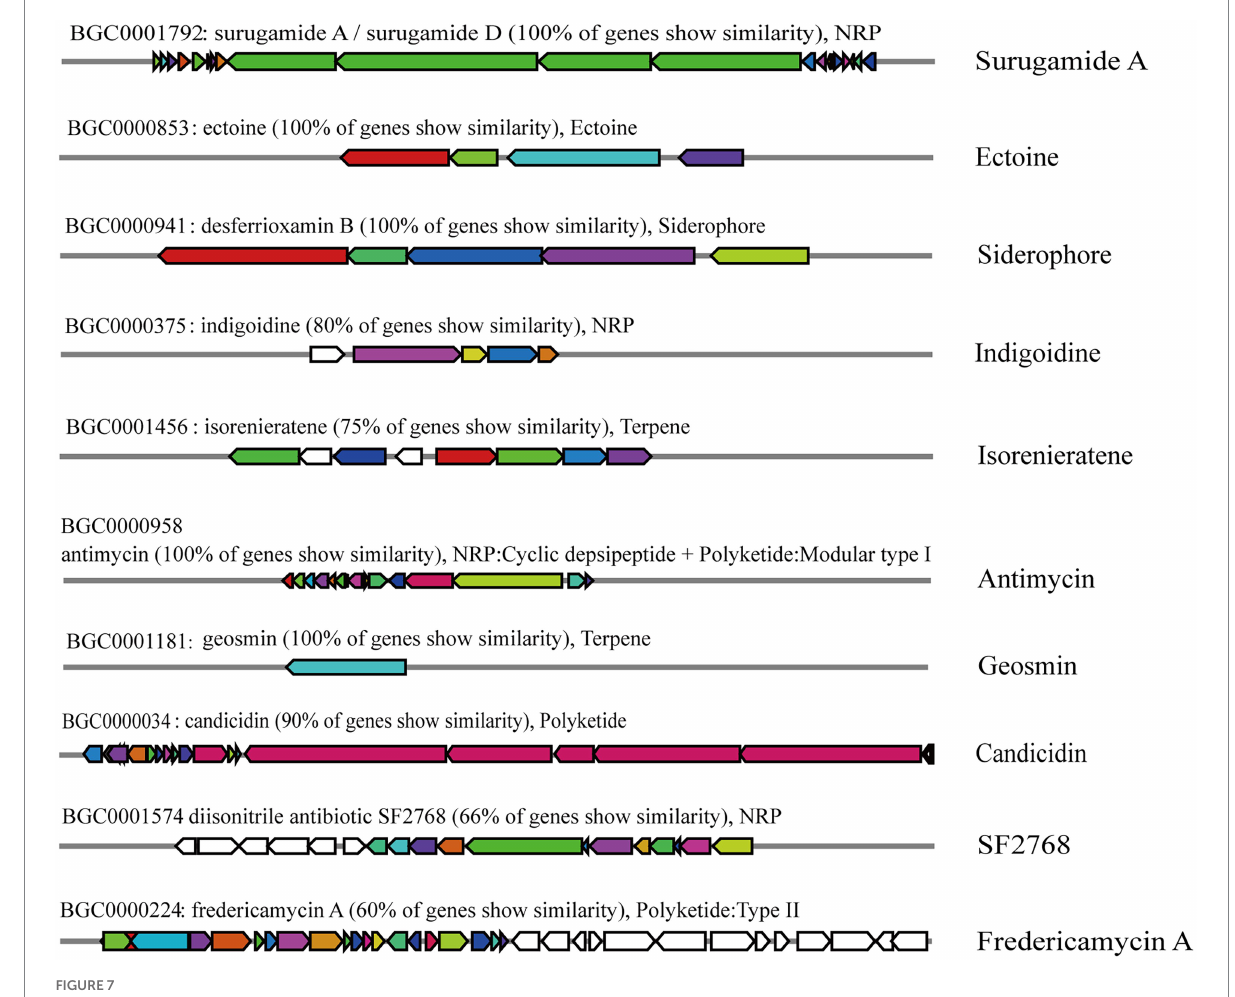
FIGURE 7 Genome-wide analysis of gene clusters related to the biosynthesis of secondary metabolites using the online antiSMASH v6.0